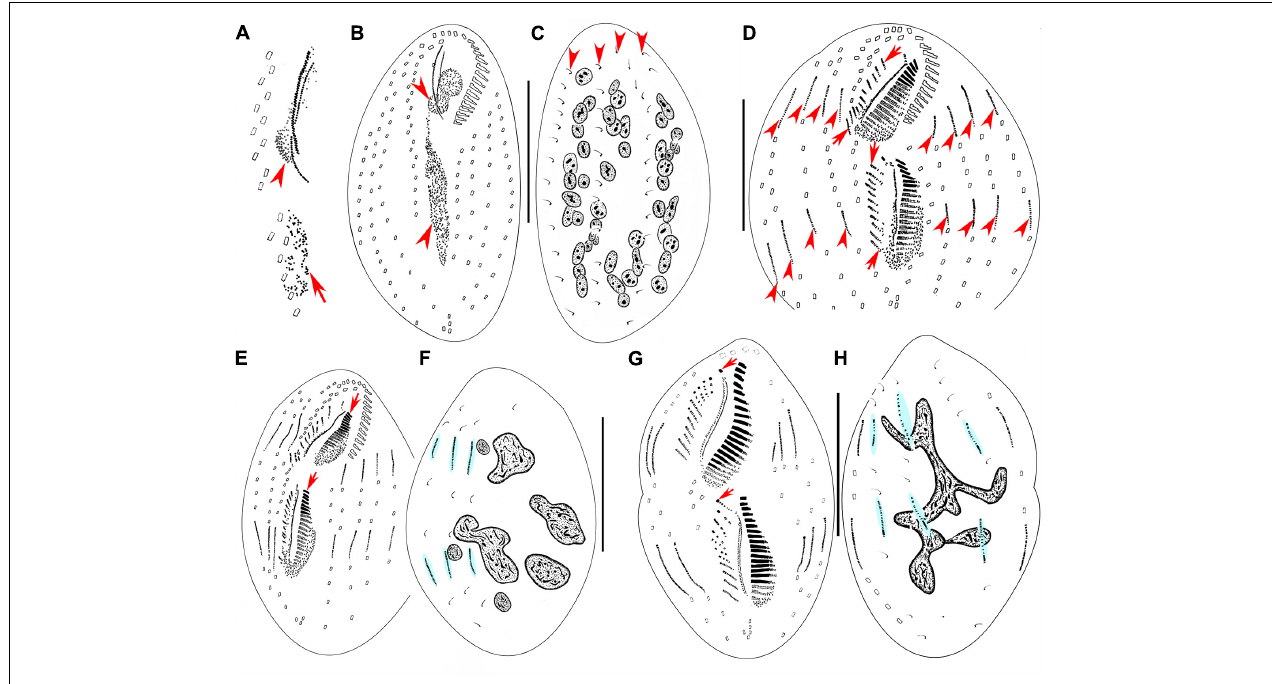
FIGURE 3 | Morphogenesis of Metaurostylopsis alrasheidi n. sp. from early to middle stages after protargol impregnation. (A) Newly formed oral primordium in proter (arrowhead) and opisthe (arrow) at very early stage. (B,C) Ventral (B) and dorsal (C) views of an early divider to show the development of oral primordia for proter and opisthe (arrowheads), and the unchanged dorsal ciliature (arrowheads). (D) Ventral view of an early-middle divider, showing the streak-like frontoventral transverse cirral anlagen (arrows) and the intrakinetally formed marginal anlagen (arrowheads). (E,F) Ventral (E) and dorsal (F) views of the same early-middle divider, to show the newly formed adoral membranelles (arrows), and dorsal kinety anlagen (shaded in light-blue). (G,H) Ventral (G) and dorsal (H) views of a middle divider, showing the leftmost frontal cirrus (arrowheads) forming from the undulating membrane anlagen, dorsal kinety anlagen (shaded in light-blue) and macronuclear nodules fusing into a mass with few branches in (H) . Scale bars = 50 µ m.